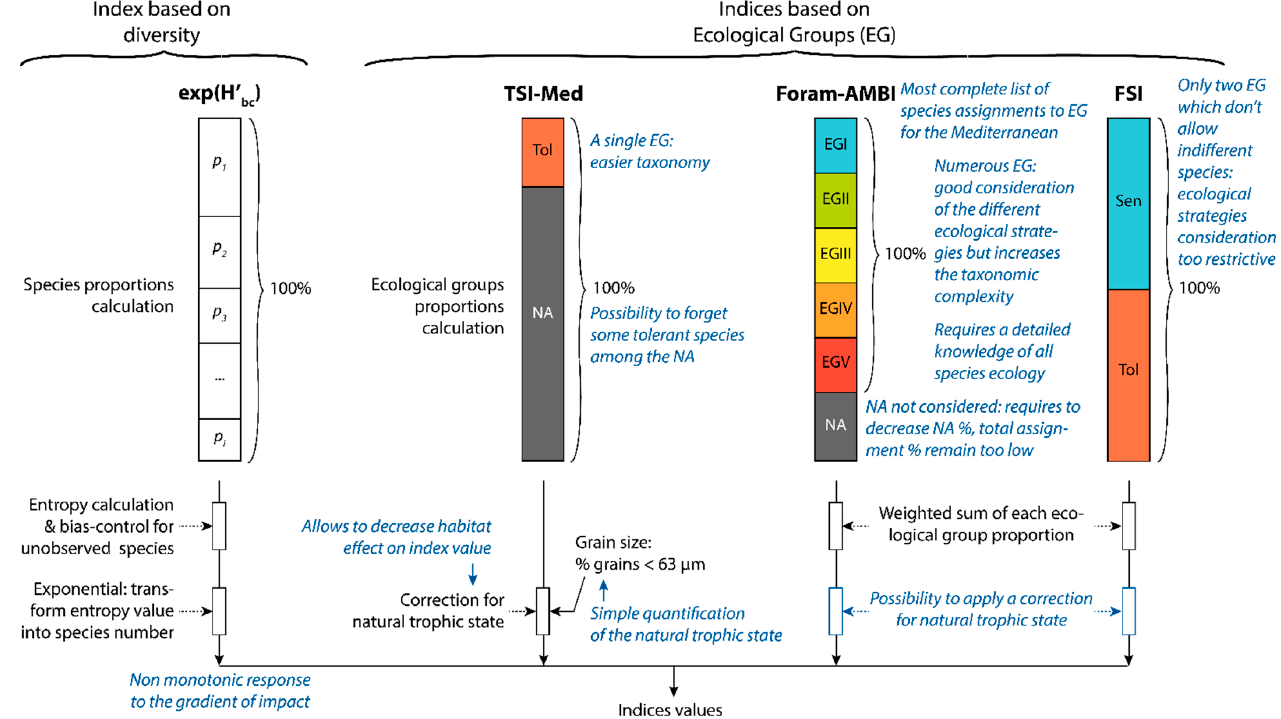
Figure 7. Calculation of the diversity-based index, exp(H’ bc ), and the three indices based on Ecological Groups (EG): TSI-Med, Foram-AMBI and FSI. Italic blue text: recommendations from this study. 100% represent the fauna included in the EG proportions calculation. p 1 , p 2 , p 3 to p i : proportions from the 1st to the i th species. EGI to EGV: Ecological Groups: sensitive, indifferent, 3rd order opportunist, 2nd order opportunist, and 1st order opportunist. Sen: stress-sensitive species and Tol: stress-tolerant species. NA: Not-Assigned species. Details on sampled stations. Figure S2: reference curves used in the corrections for the natural trophic state. Table S3: Species assignment for the biotic indices based on groups of indicator species (TSI-Med, Foram-AMBI, and FSI). Species listed in Table S3 correspond to the species assigned in this study, and they do not correspond to a complete list of all species assigned by each biotic index. Table S4: Indices regression models including only samples with less than 20% unassigned species.